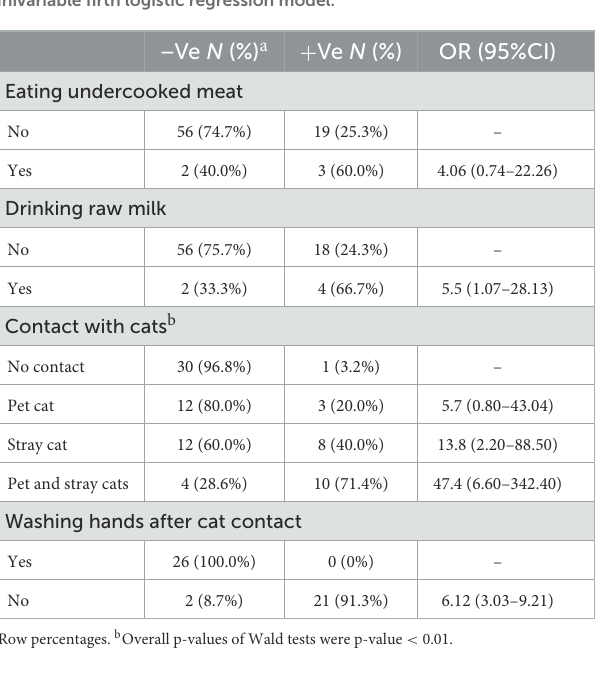
FrontiersinVeterinaryScience